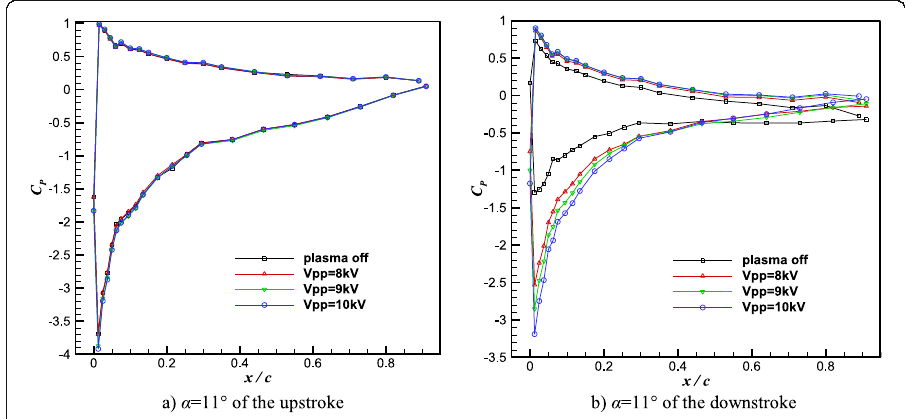
Fig. 9 The effect of actuation duty cycle on the pressure